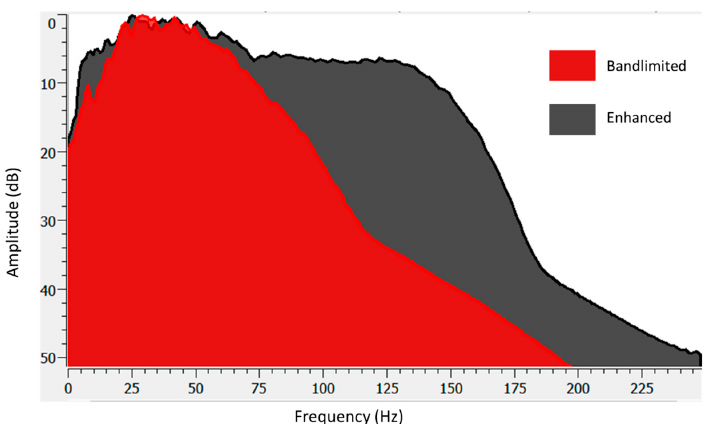
Figure 17. Inas Field seismic data spectrum showing the original and enhanced spectral bandwidths. The seismic trace at the well (Inas-1) intersection was extracted from both the en- hanced and original trace for further comparison. In Figure 18, the synthetic seismogram generated from the same well was compared to both traces. The enhanced trace (Track 2) has a shorter wavelength, better resolution, and a stronger correlation to the synthetic seismogram (Track 1) than the original trace (Track 3). An overlay of both traces on the same track (Track 4) reveals a considerable difference in the magnitude of the reflection strengths (reflection coefficients), with the exception of a few reflectors where the magni- tudes are equal, as indicated by the dotted black circles.